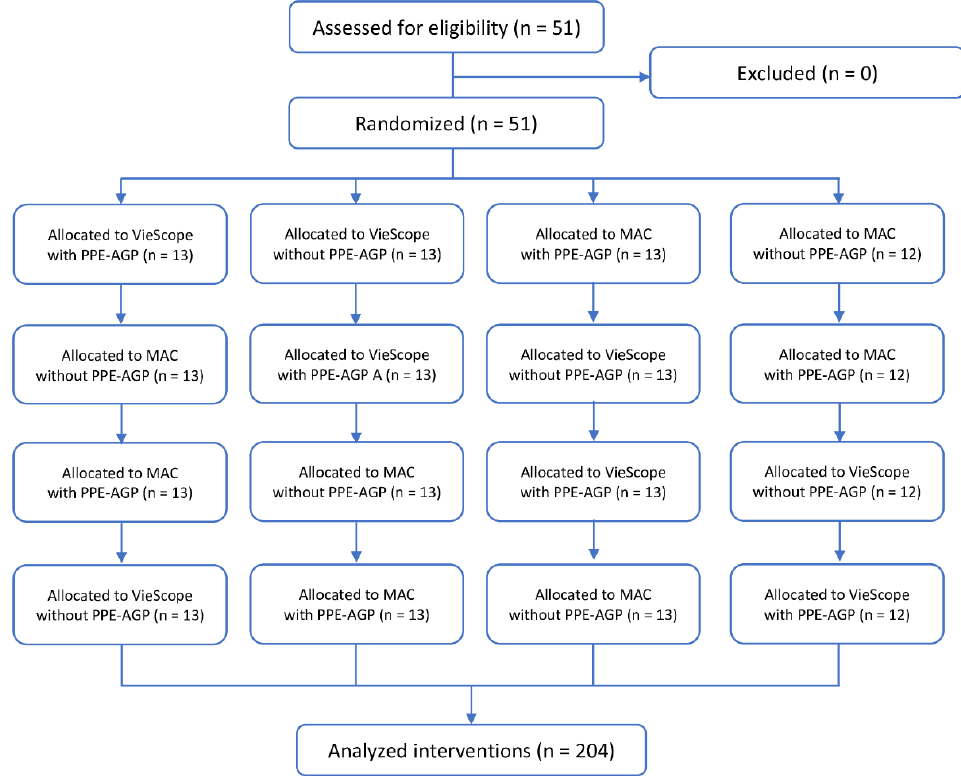
Figure 2. Randomization flow chart. Legend: MAC = Macintosh laryngoscope; PPE-AGP = personal pro- tective equipment for aerosol-generating